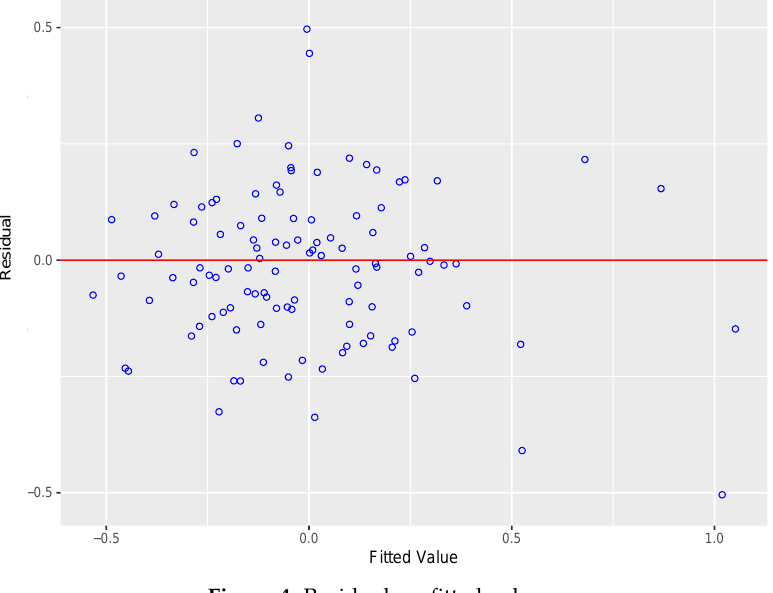
Figure 4. Residual vs. fitted values.